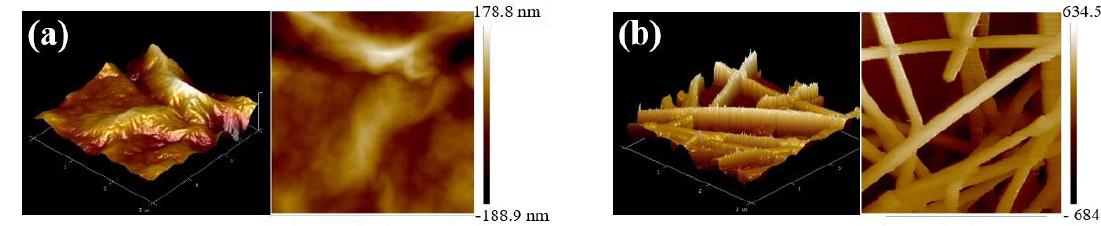
Figure 9. AFM images of ( a ) the rGO/NiO, and ( b ) the AgNW/rGO/NiO. Table 1. R a and R q of the rGO/NiO and the AgNW/rGO/NiO films. Table 1. R a and R q of the rGO/N i O and the AgNW/rGO/N i O films . Films